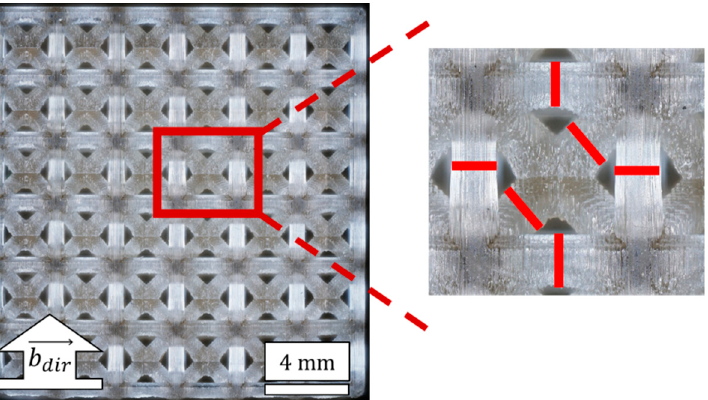
Figure 3. Microscopy of lattice side face and demonstrated measurements for beam diameters aligned (0°), diagonal (45°), and perpendicular (90°) to the build direction.